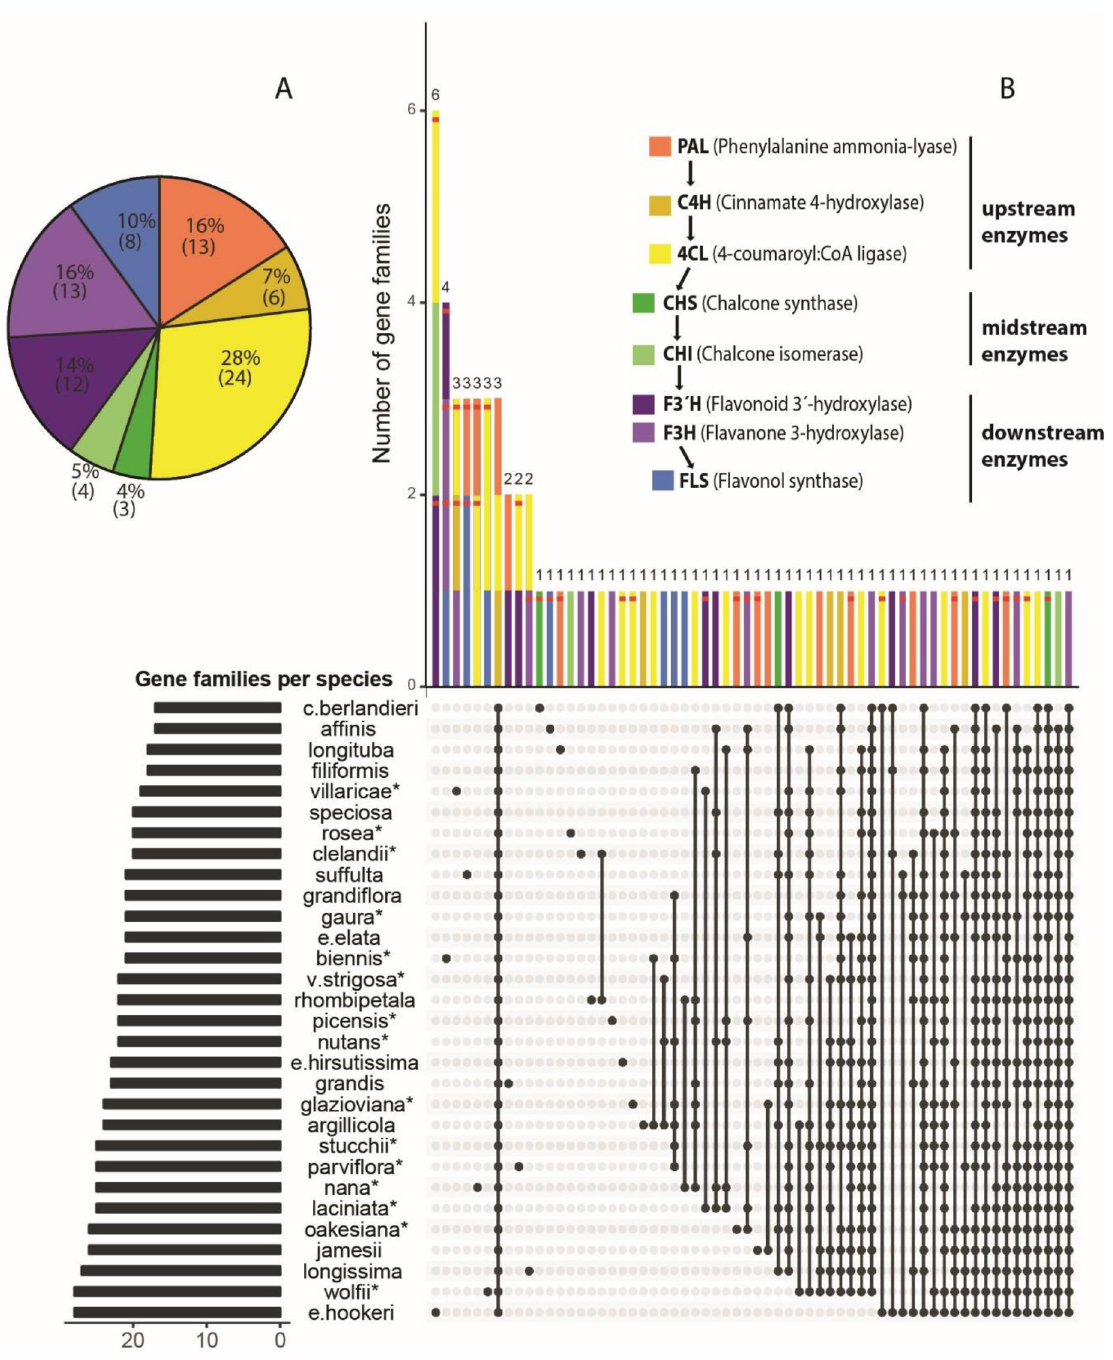
Fig 2. Distribution of phenolic-related genes in 30 Oenothera taxa. (A) The relative proportion of 83 gene families related to major enzymes involved in the synthesis of phenolic compounds. (B) shows intersections of major phenolic up- mid- and downstream enzyme related-genes from Oenothera transcriptomes. In the upper panel each color bar corresponds to a single or a set of gene families matching to specific pattern of species intersection. Red-striped bars indicate 33 rapidly evolved gene families based on the CAFE analysis. Filled circles in the bottom panel indicate the presence of phenolic-related genes per taxa. Connected circles indicate shared gene families among taxa. Lower left panel indicate the number of gene families corresponding to each filled-circle pattern.